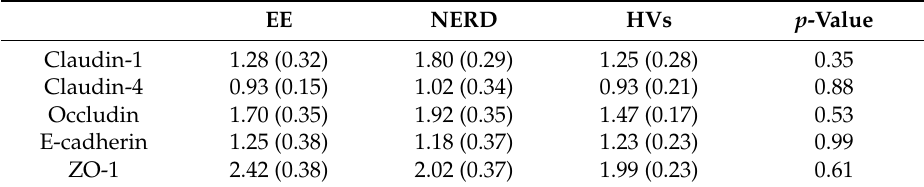
Table 2. Normalized expression ratio of tight junction proteins.